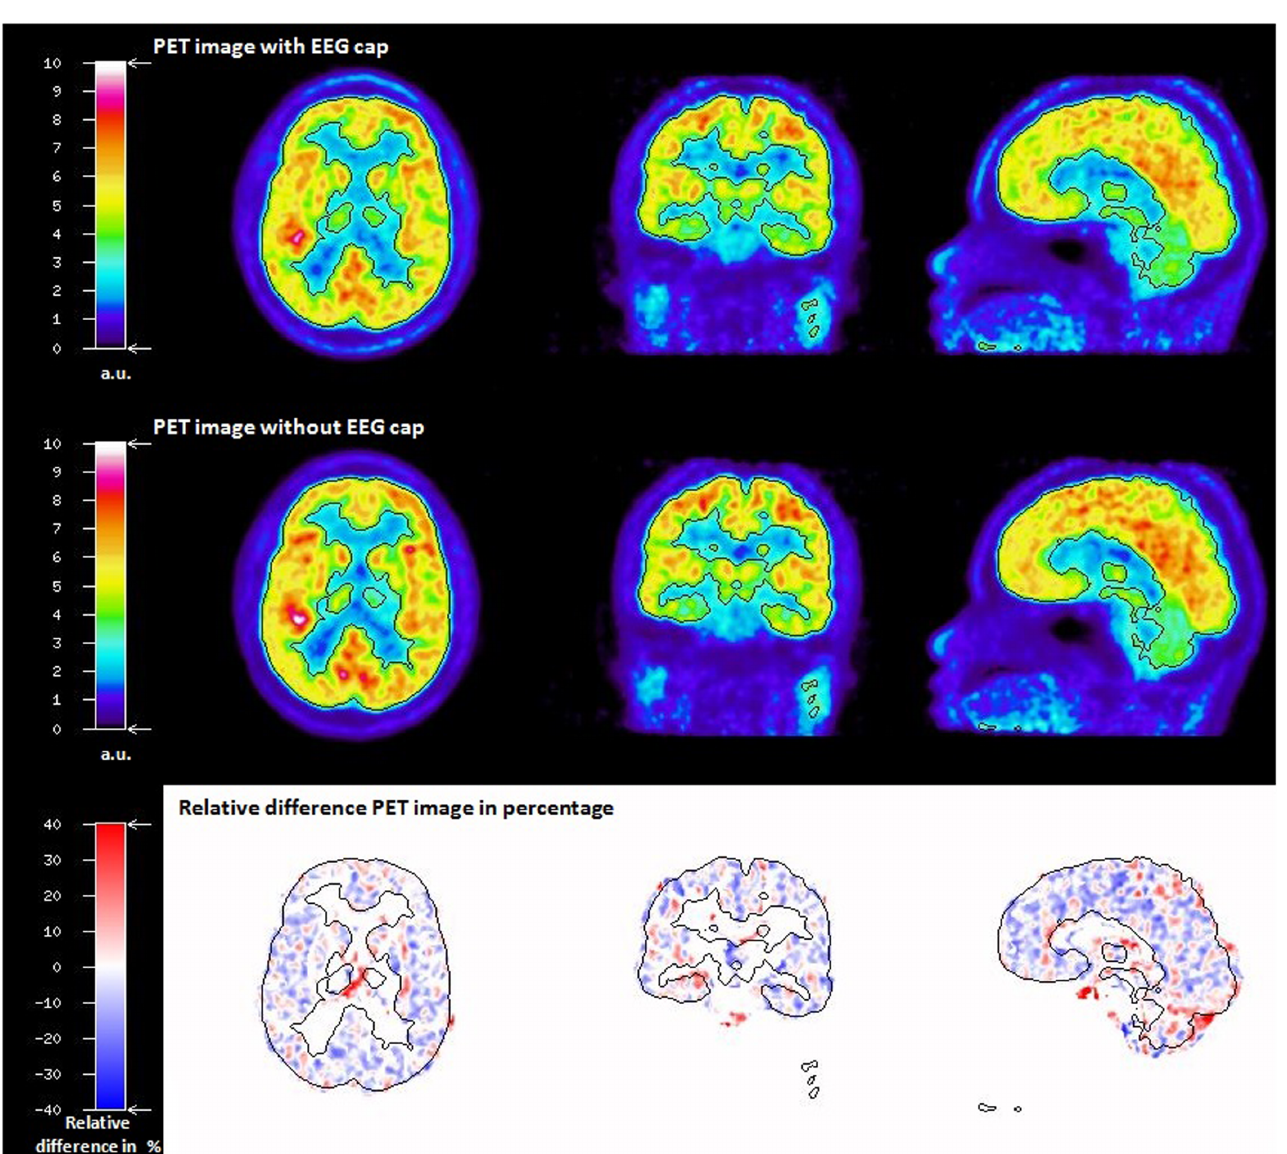
Fig 7. FDG PET SUV image of a human subject with EEG cap (top row) and without EEG cap (middle row), both reconstructed with an AC map without EEG cap; relative difference image in percentage between the above FDG PET images (bottom row).